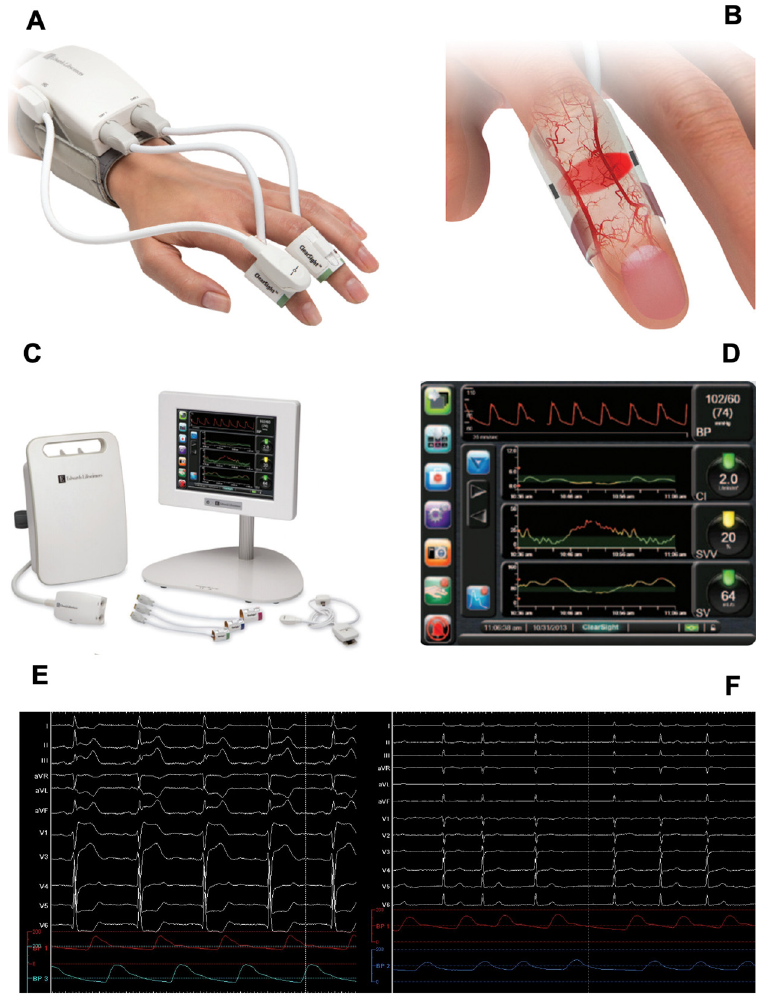
Figure 1. ( A ) ClearSight device when in use, with cuff placed on the first finger. ( B ) Representation of ClearSight finger-cuff device sampling digital arteries pulsation. ( C ) ClearSight monitor and patient hardware. ( D ) Screenshot of main ClearSight parameter view, showing CNBP tracing, cardiac index, stroke volume, and stroke volume variability live values and relative plots. ( E , F ) Live polygraph showing IBP (red line) and CNBP (blue line) curves alongside surface ECG, both during sinus rhythm ( E ) and atrial fibrillation ( F ).